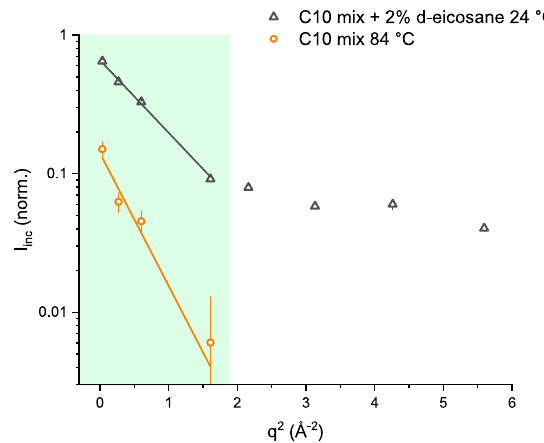
Fig. 8 Elastic intensity decay and GA validity range. Example of intensity curves obtained from the EINS experiment and range of validity of the GA (shown as a linear behaviour in this representation). The data shown are the ones of C10 mix and C10 mix + 2% eicosane at p = 10 bar and T = 84 and 24 °C, respectively. The light green region highlights the q 2 data range used for the analysis. The q 2 > 2 Å − 2 data for the C10 mix at T = 84 °C approach zero and are not visible in the log( I inc ) representation. The errors are obtained from Poisson